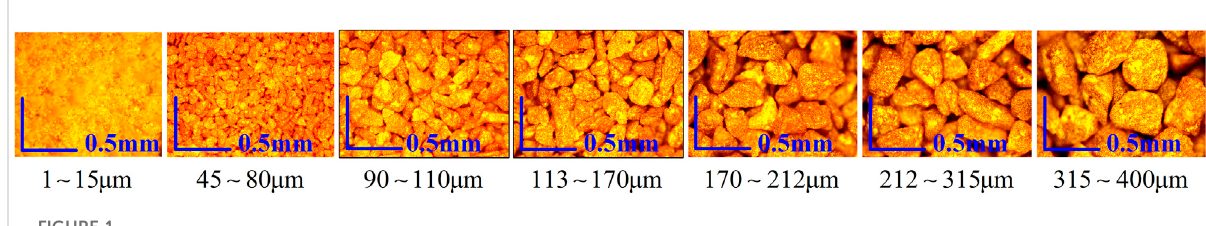
FIGURE 1 Preparation process of PZT piezoelectric ceramic powder.